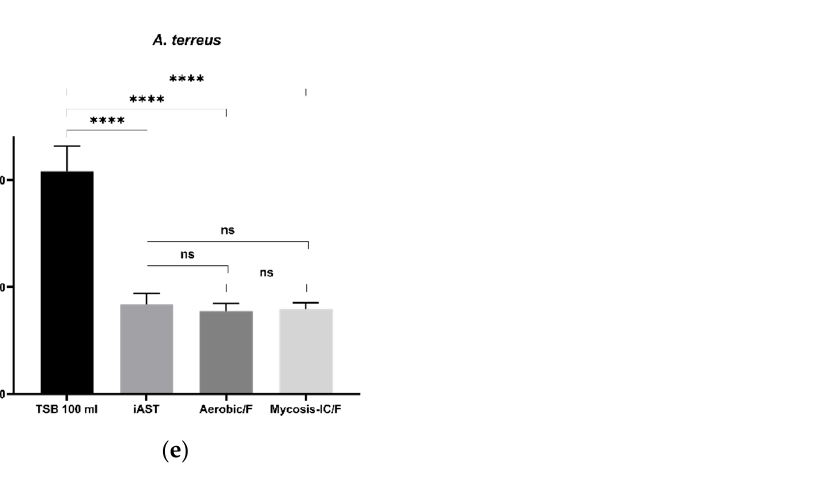
Figure 1. Time to Detection (TTD) of Aspergillus spp. with the manual method (TSB), the BacT/Alert 3D 60 system (iAST), and the BACTEC 9020 system (Aerobic/F or Mycosis-IC/F). ( a ) A. brasiliensis ; ( b ) A. niger ; ( c ) A. fumigatus ; ( d ) A. flavus ; ( e ) A. terreus ; In each figure, the bar represents the standard deviation of the mean. Symbols above comparative bars denoting statistically significant differences among groups as follows: ns: no significant difference ( p > 0.05), * = p < 0.05, ** = p < 0.01, *** = p < 0.01, **** = p < 0.001.